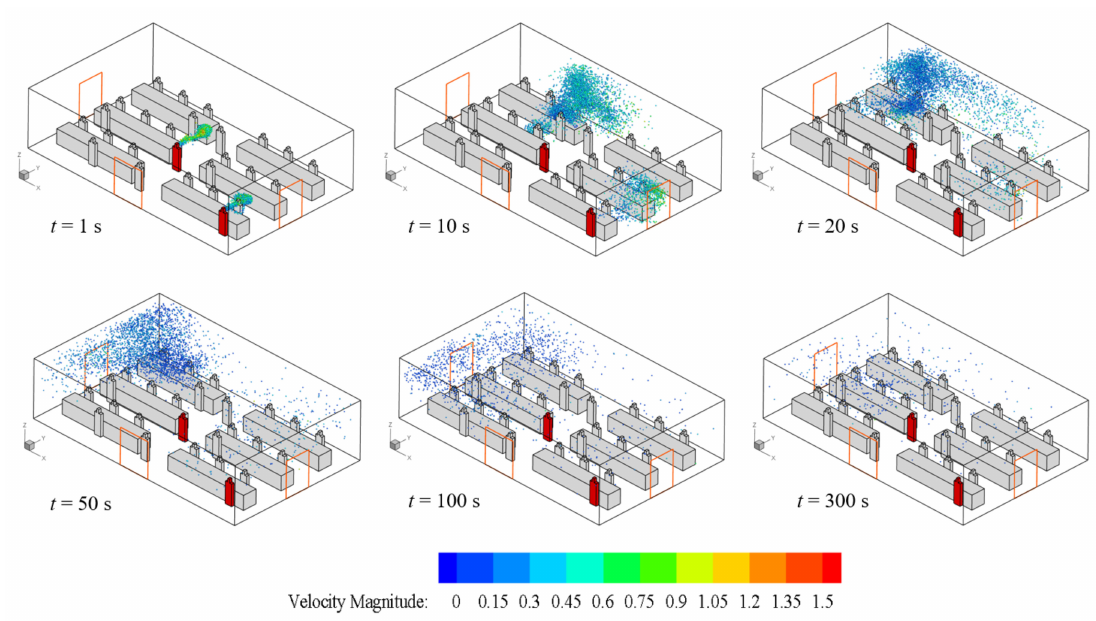
Figure 7. Distribution of aerosols in case 3 (front, left, and right doors are open).